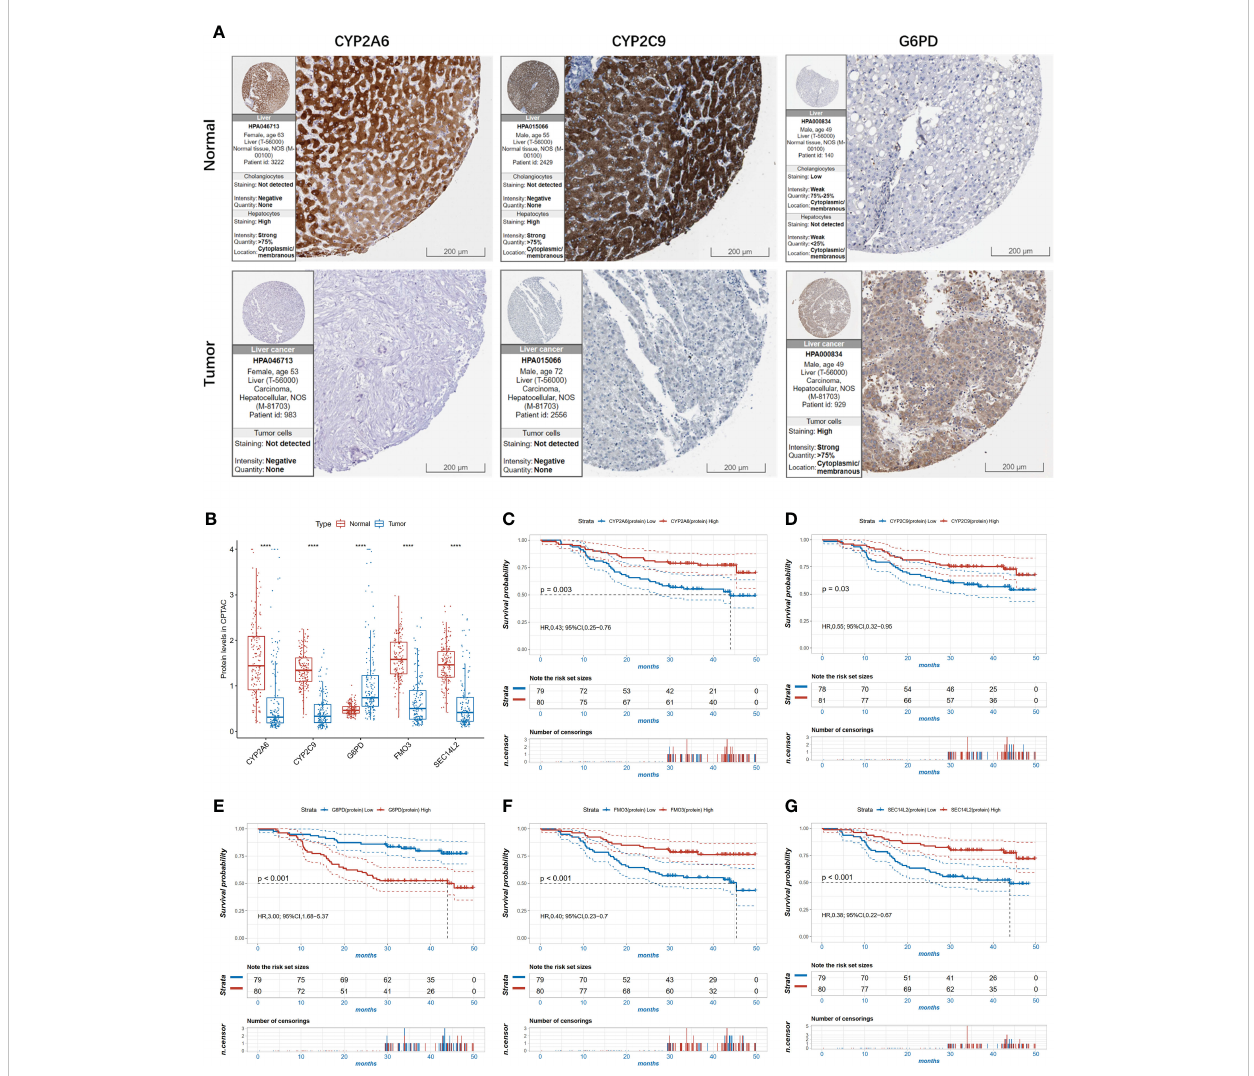
FIGURE 6 The expression level of the 5 proteins in HCC. (A) The immunohistochemistry (IHC) results from the Human Protein Atlas (HPA) was used to detect the protein level of three proteins in normal and tumor tissues; (B) The expression of the 5 proteins in proteomic level in normal and tumor tissues in the CPTAC cohort, ****P<0.0001.; (C – G) Kaplan-Meier survival curves of high and low expressed CYP2A6 (C) ; CYP2C9 (D) ; G6PD (E) ; FMO3 (F) ; SEC14 (G) in the CPTAC